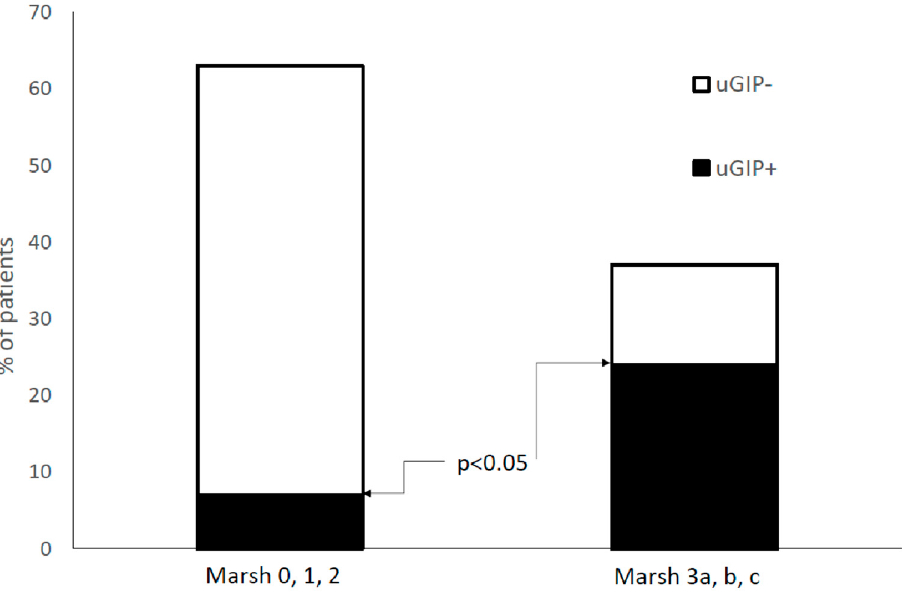
Figure 1. Rate of celiac patients with or without duodenal atrophy and with or without positive urinary gluten immunogenic peptides (uGIP).